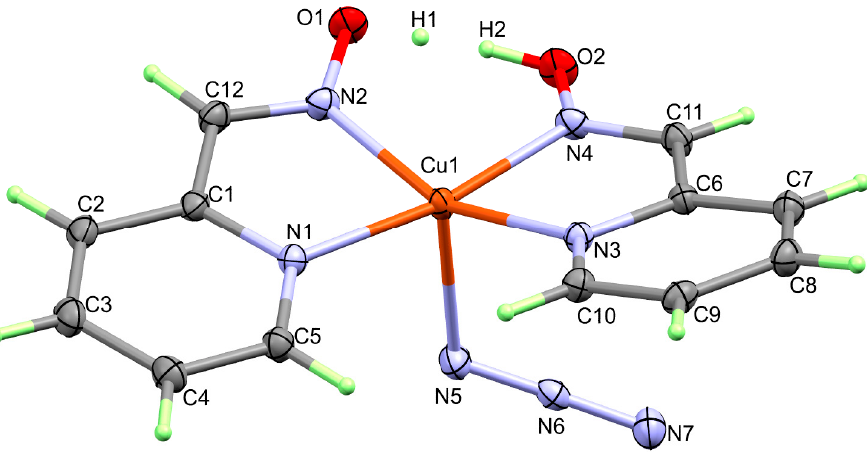
Figure 4. Packing scheme of compound 1 . The projections along [100] ( A ) and [010] ( B ) directions, respectively. Hydrogen atoms are omitted in both projections. Table 3. Hydrogen bonds in complex 1 .